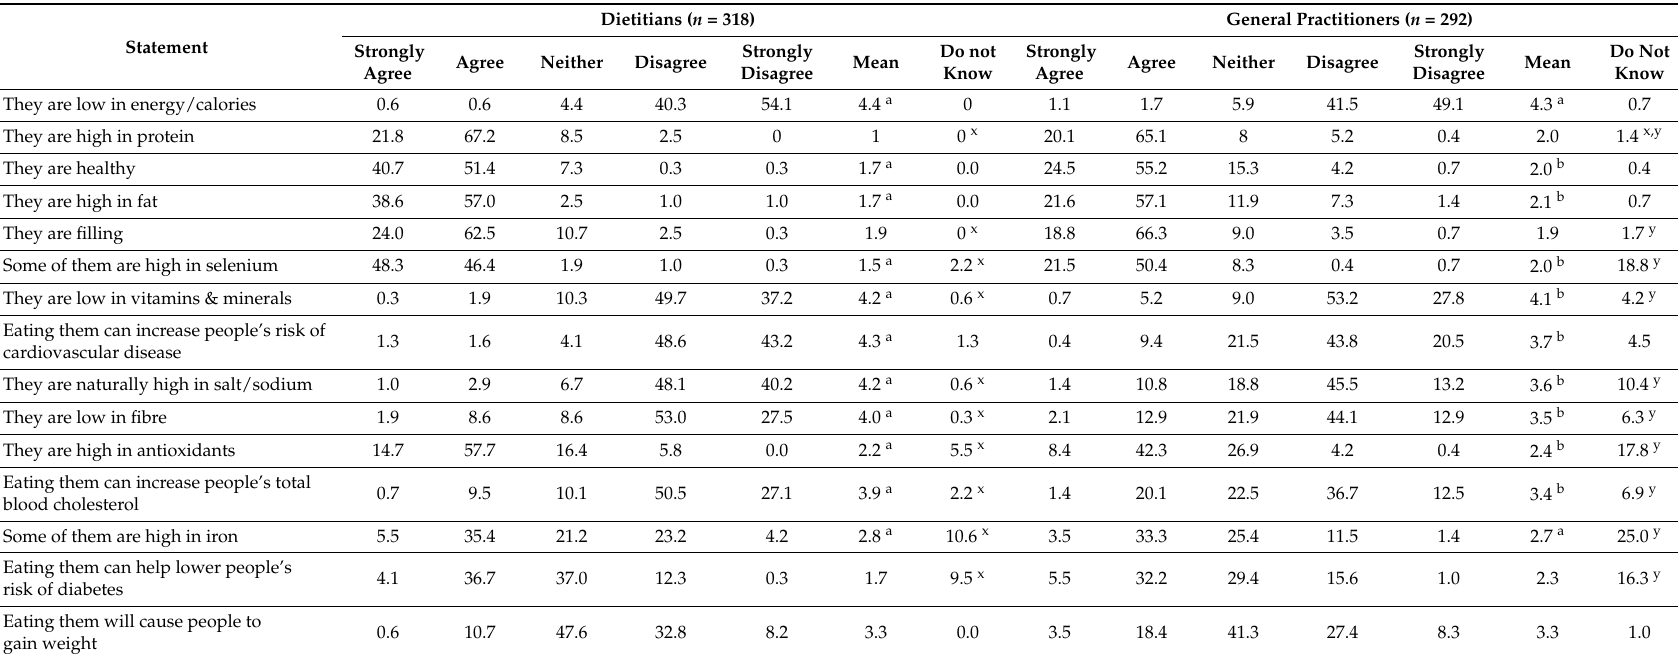
Table 3. Responses from health professionals (%) regarding the perceptions and knowledge of nuts and nut